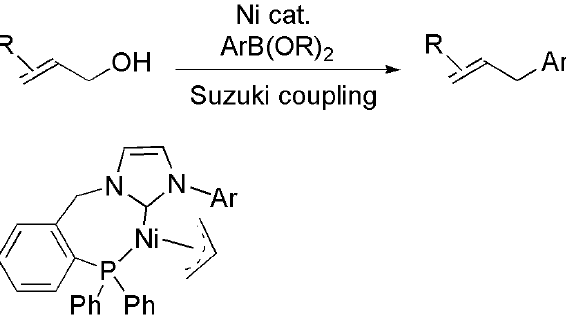
Figure 24. Nickel ‐ based NHC ligand for Suzuki coupling [195]. Figure 24. Nickel-based NHC ligand for Suzuki coupling